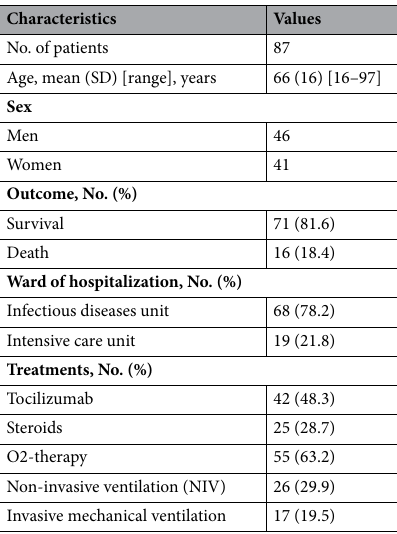
Table 1. Demographics and clinical information of study